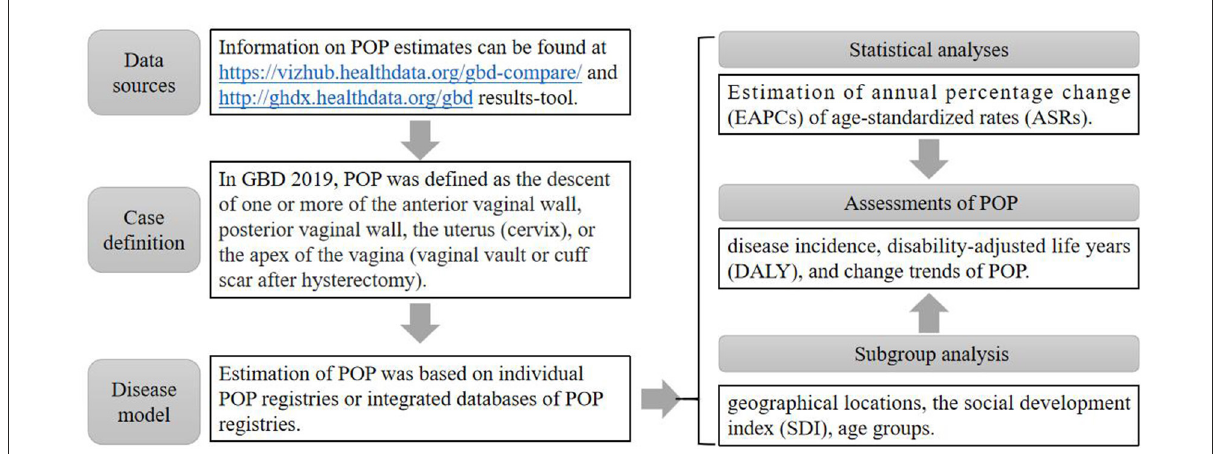
FIGURE1 Flow chart of GBD data acquisition. Notes. ASR is assumed to be linear along with time; that is, Y = α + β X + ε , where Y refers to ln (ASR), X the calendar year, and ε the error term. Based on this formula, β represents the positive or negative ASR trends. The EAPC was calculated as EAPC = 100 × (exp( β )-1). Its 95% confidence intervals (CI) could be obtained from the linear model. Disability-adjusted life-years for any corresponding subpopulation of a specific cause was the sum of the corresponding YLDs and YLLs. YLLs: years of life lost; YLDs: years lived with disability.